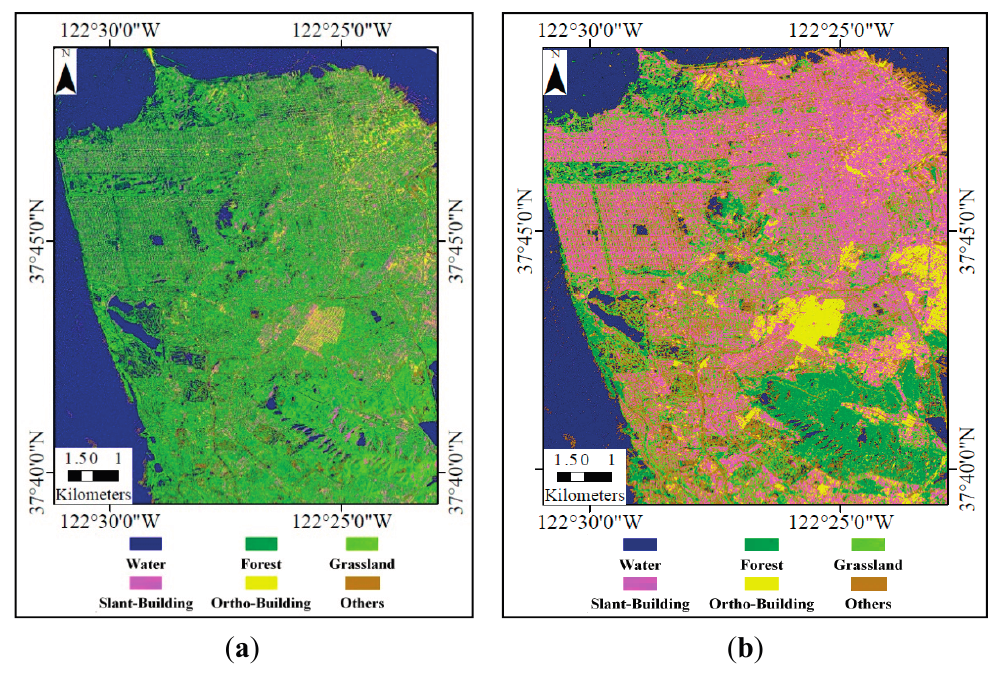
Figure 5. Classification Results of Wishart supervised and proposed method. ( a ) Classification result obtained by Wishart supervised classification method; and ( b ) Classification result obtained by the proposed method.